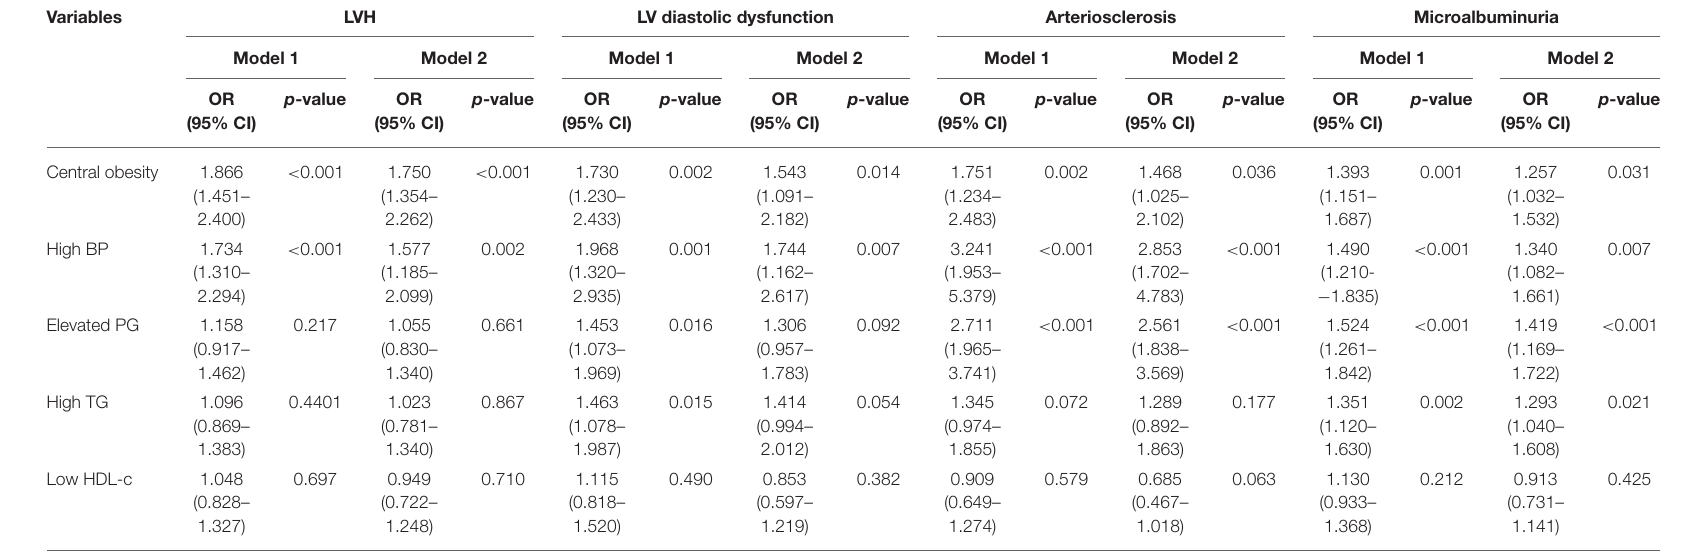
TABLE 4 | Association of asymptomatic cardiovascular impairments with individual components of MS.